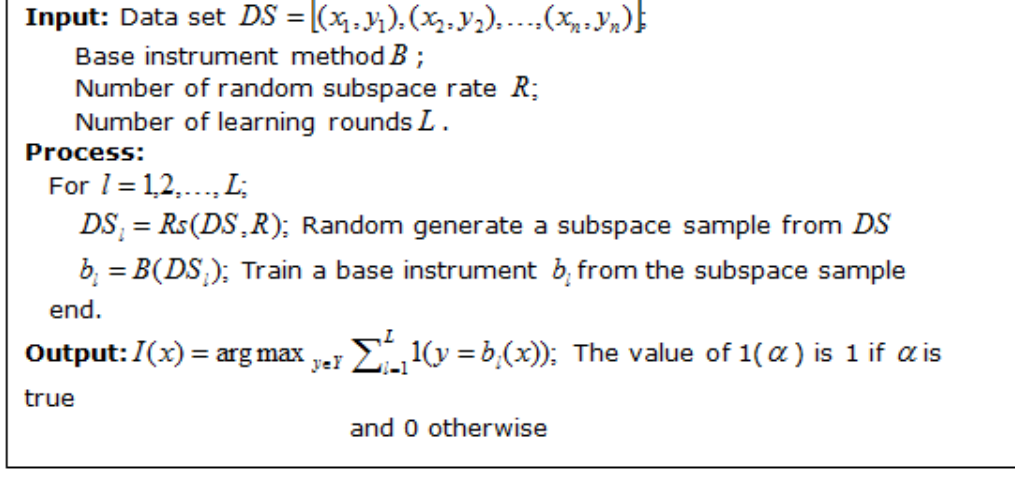
Figure 1. The RSM approach (Wang & Ma,